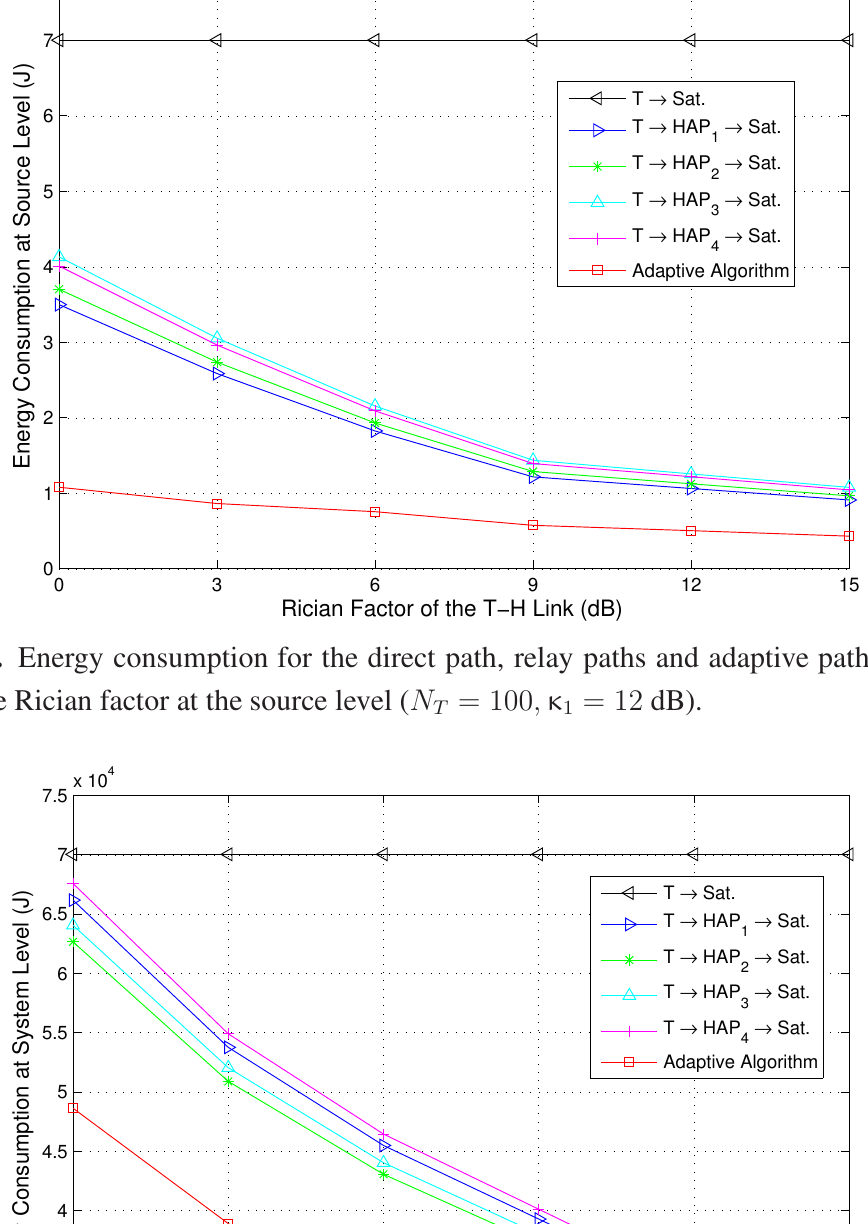
Figure 8. Energy consumption for the direct path, relay paths and adaptive path selection versus the Rician factor at the system level ( N